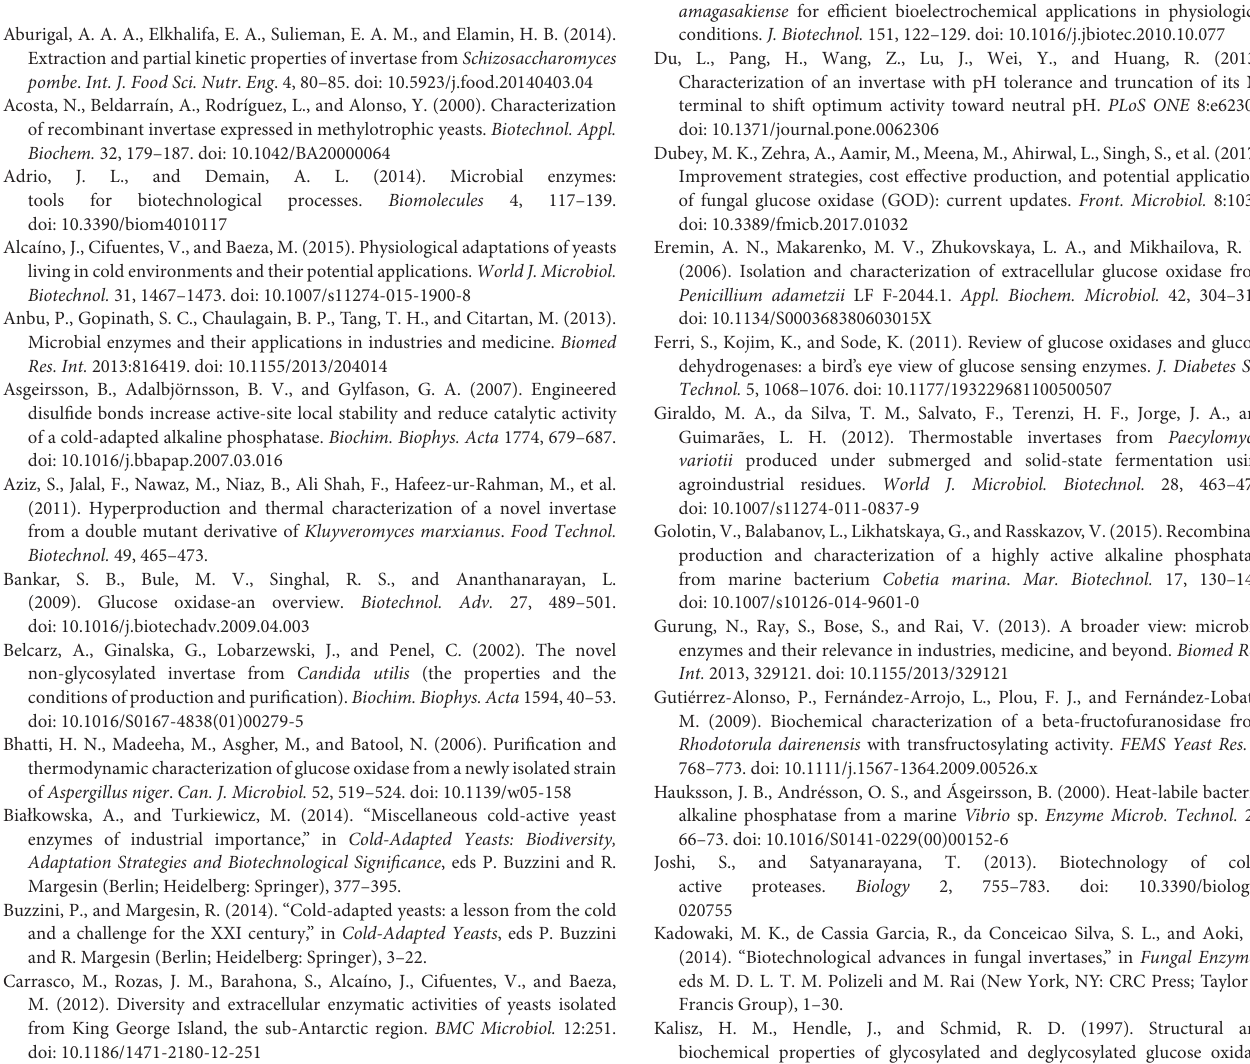
bottom of the gels, the presence ( + ) or absence ( − ) of the respective activity is indicated. Figure S2 | Reaction rate in relation to substrate concentration. (A) , GOD; (B) , Inv; (C) ALP. The total amount of enzyme used in each assay was 15, 39, or 39 ug of GOD, Inv, or ALP, respectively. Figure S3 | Thermal inactivation of enzymes. Arrhenius plots for GOD (circles), Inv (squares), and ALP (triangles) are shown. The total amount of enzyme used in each assay was 15, 39, or 39 ug of GOD, Inv, or ALP, respectively; the substrate concentration used was 280, 100, or 5mM of glucose, sucrose or pNPP, respectively. Table S1 | Plackett-Burman design and calculation of the effect of physical-chemical parameters on enzyme activity. Table S2 | Enzyme activities at different temperature and pH. Enzyme activity levels were determined as the change of absorbance at 500nm for GOD, 540nm for Inv, and 405nm for ALP and normalized by total protein amount in each sample. The substrate concentration used was 280, 100 or 5mM of glucose, sucrose or